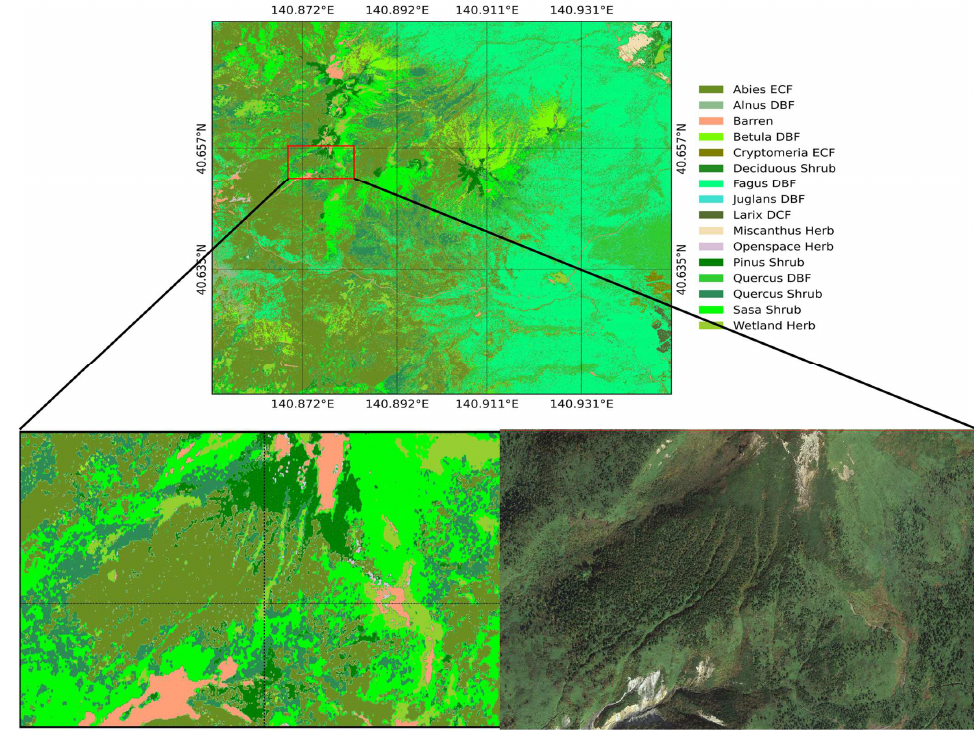
Figure 16. Ultra-resolution map with 16 classes produced for the Hakkoda site ( top ). The red polygon area has been zoomed in to show finer details ( bottom left ) along with the true-color composite image ( bottom right ).